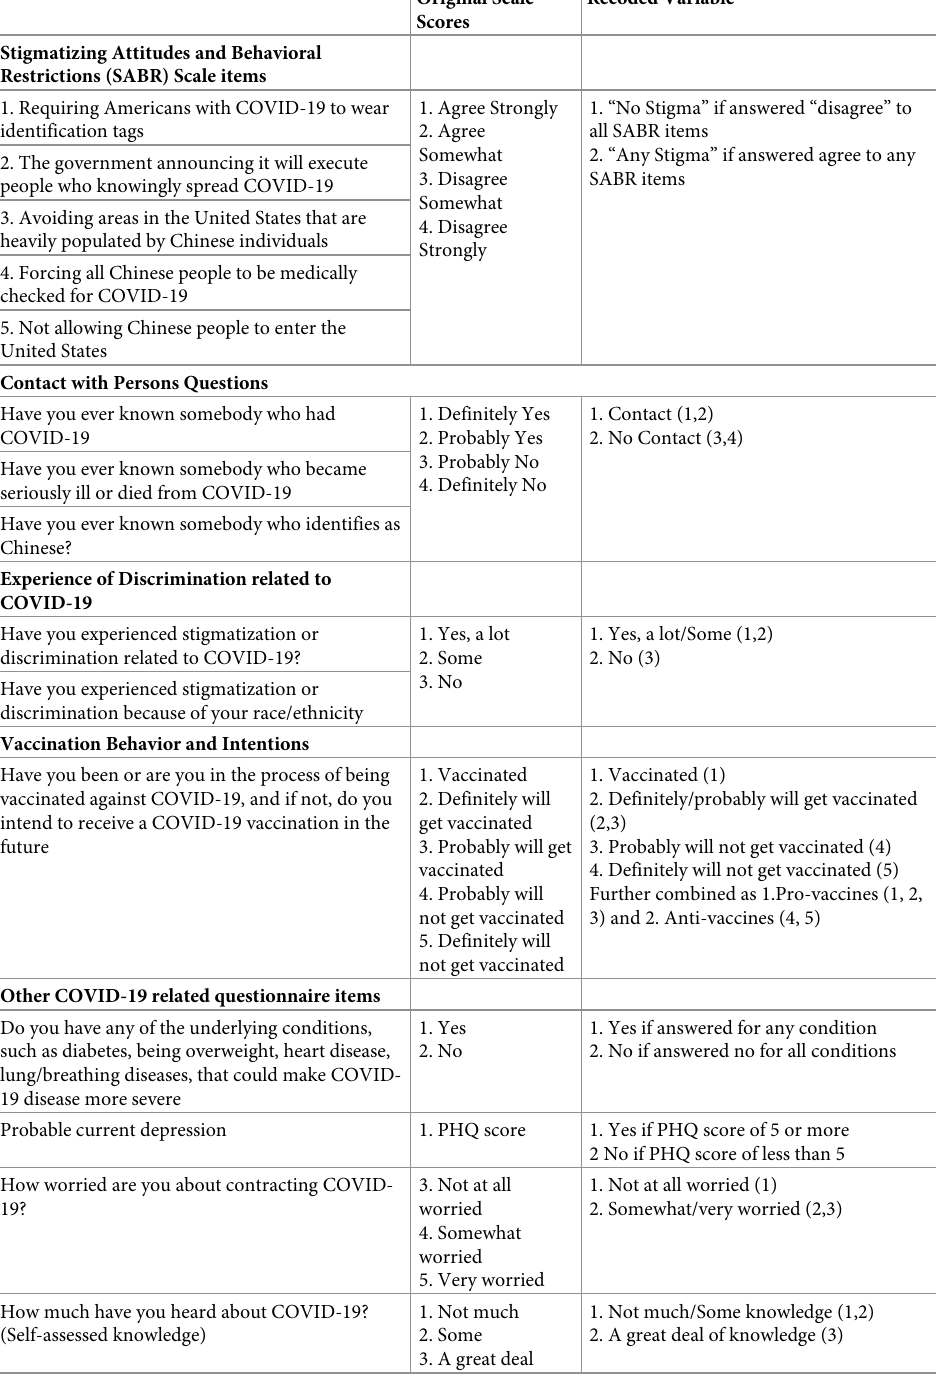
Table 1. List of different COVID-19 related questions and variables and recoding schemes for